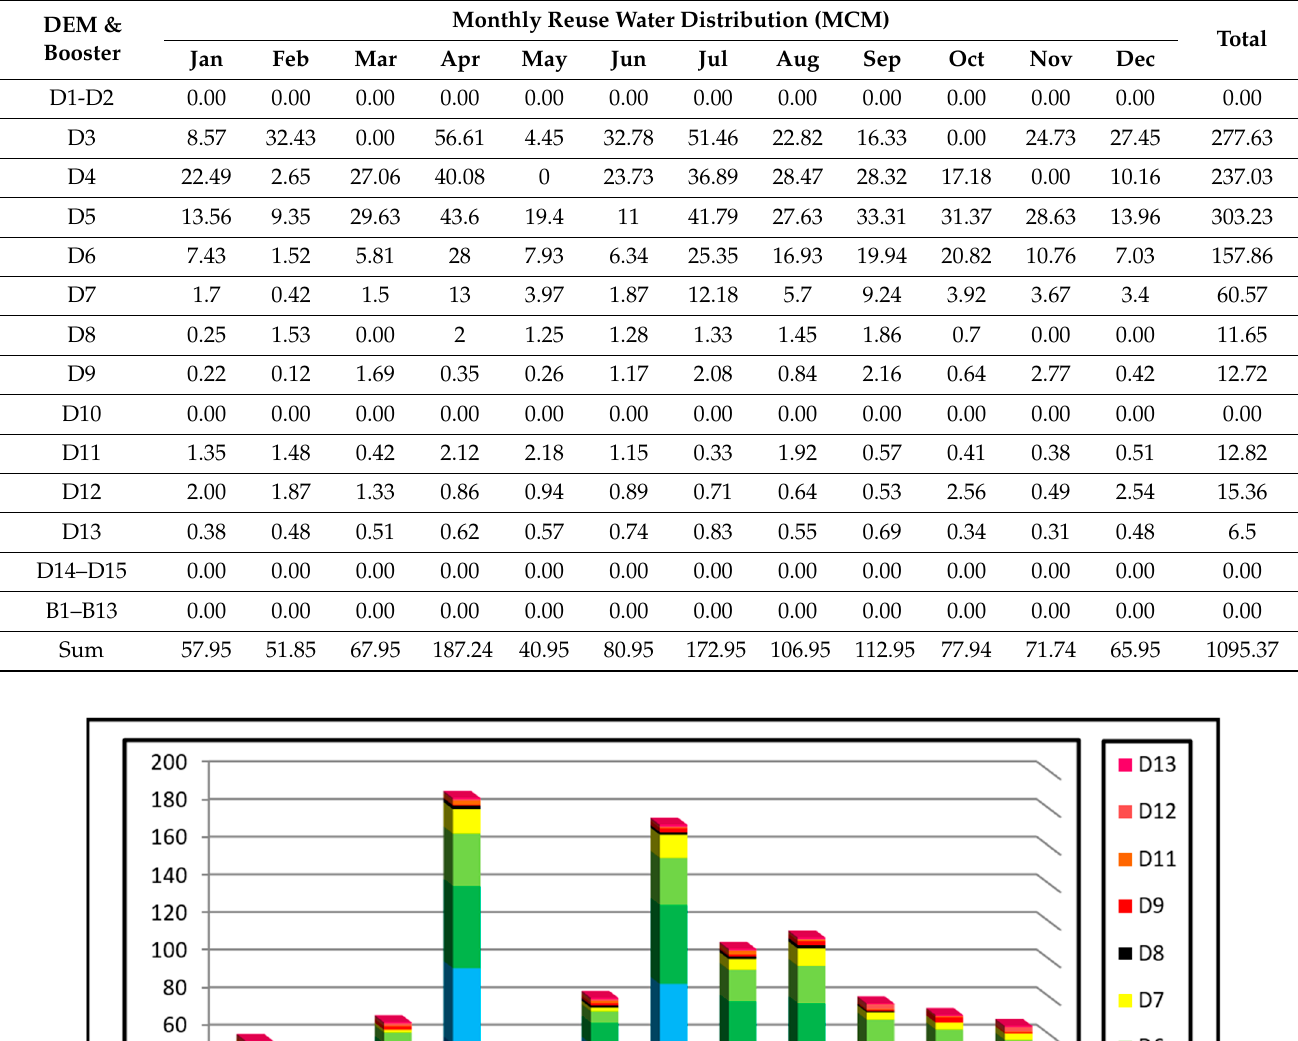
Table 10. Monthly reuse water distribution in the study area (MCM).